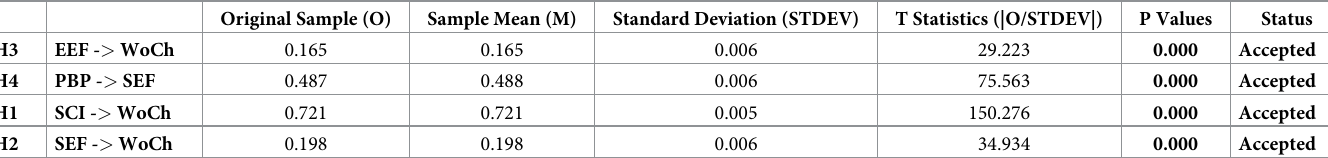
Table 4. Hypotheses testing.